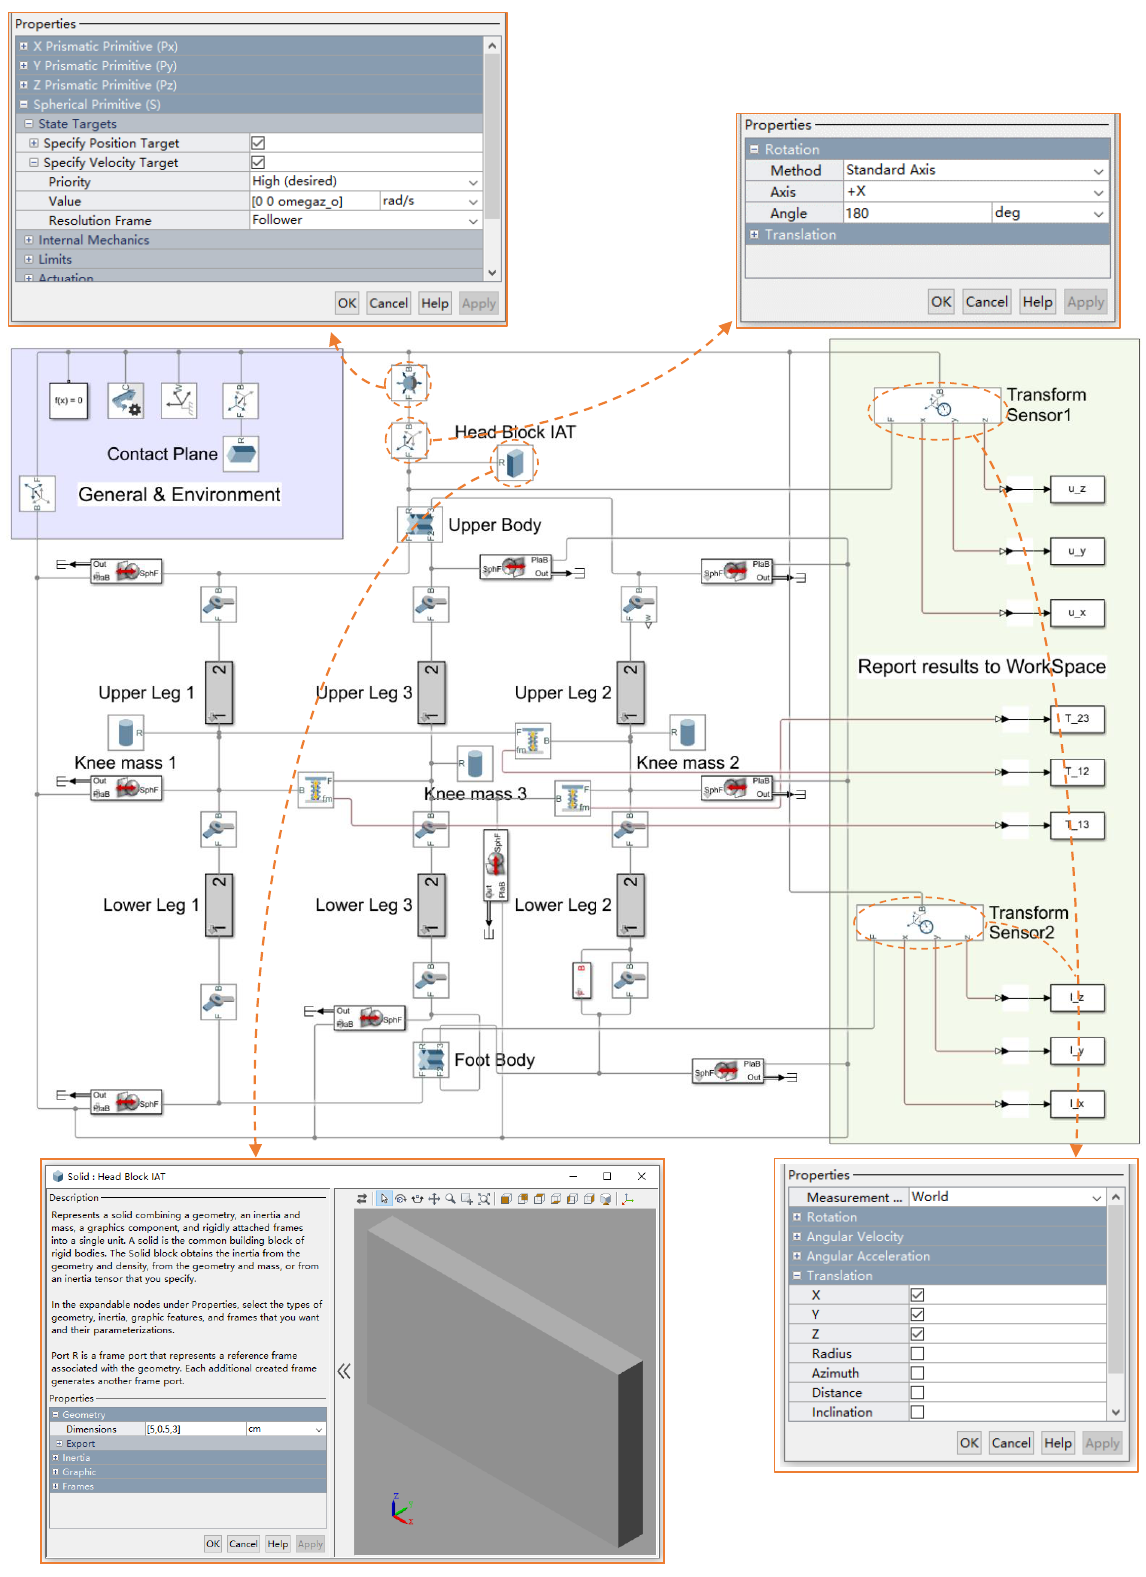
Figure 10. Modified Simulink block diagram for the IAT simulation and four marked modules.